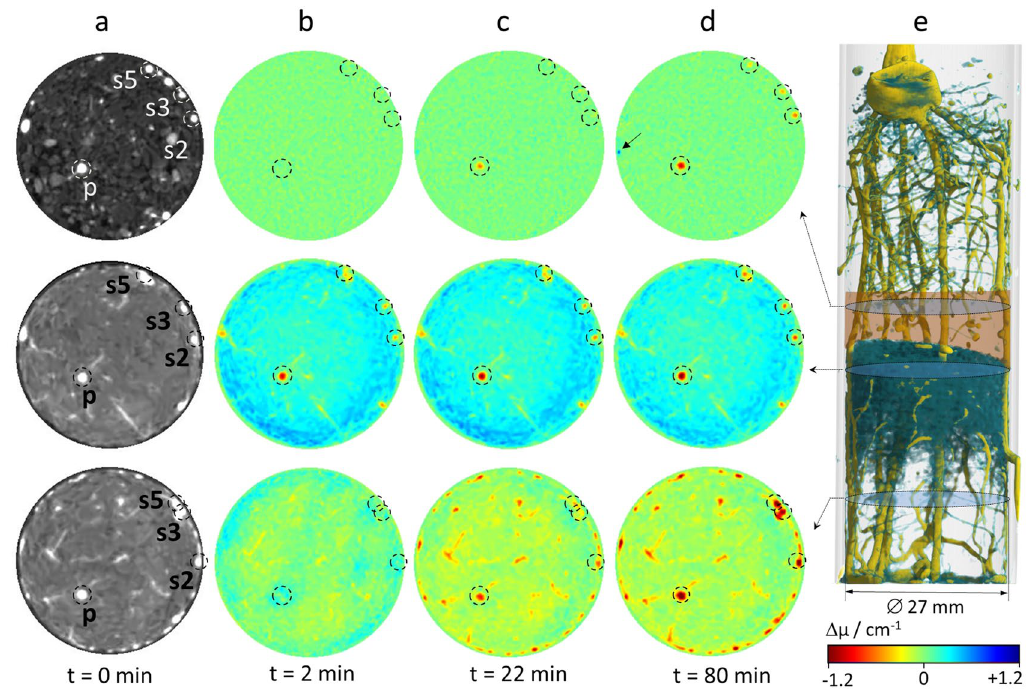
Figure 3. 2D cross sectional views of a soil column with a 13-days-old maize root system displayed in regular grey scale ( a ) and as difference images with reference to t = 0 min ( b - d ). Position of cross sections in the root- soil column (3D-rendered at t = 6 min) is indicated in ( e ). Changes in neutron attenuation over time reveal the dynamic soil water redistribution and root uptake after infiltration of D 2 O at the bottom of the soil column. Primary (p) and three selected seminal roots (s2, s3 and s5) are marked with dashed circles. The colour bar displays the change in local neutron attenuation coefficient